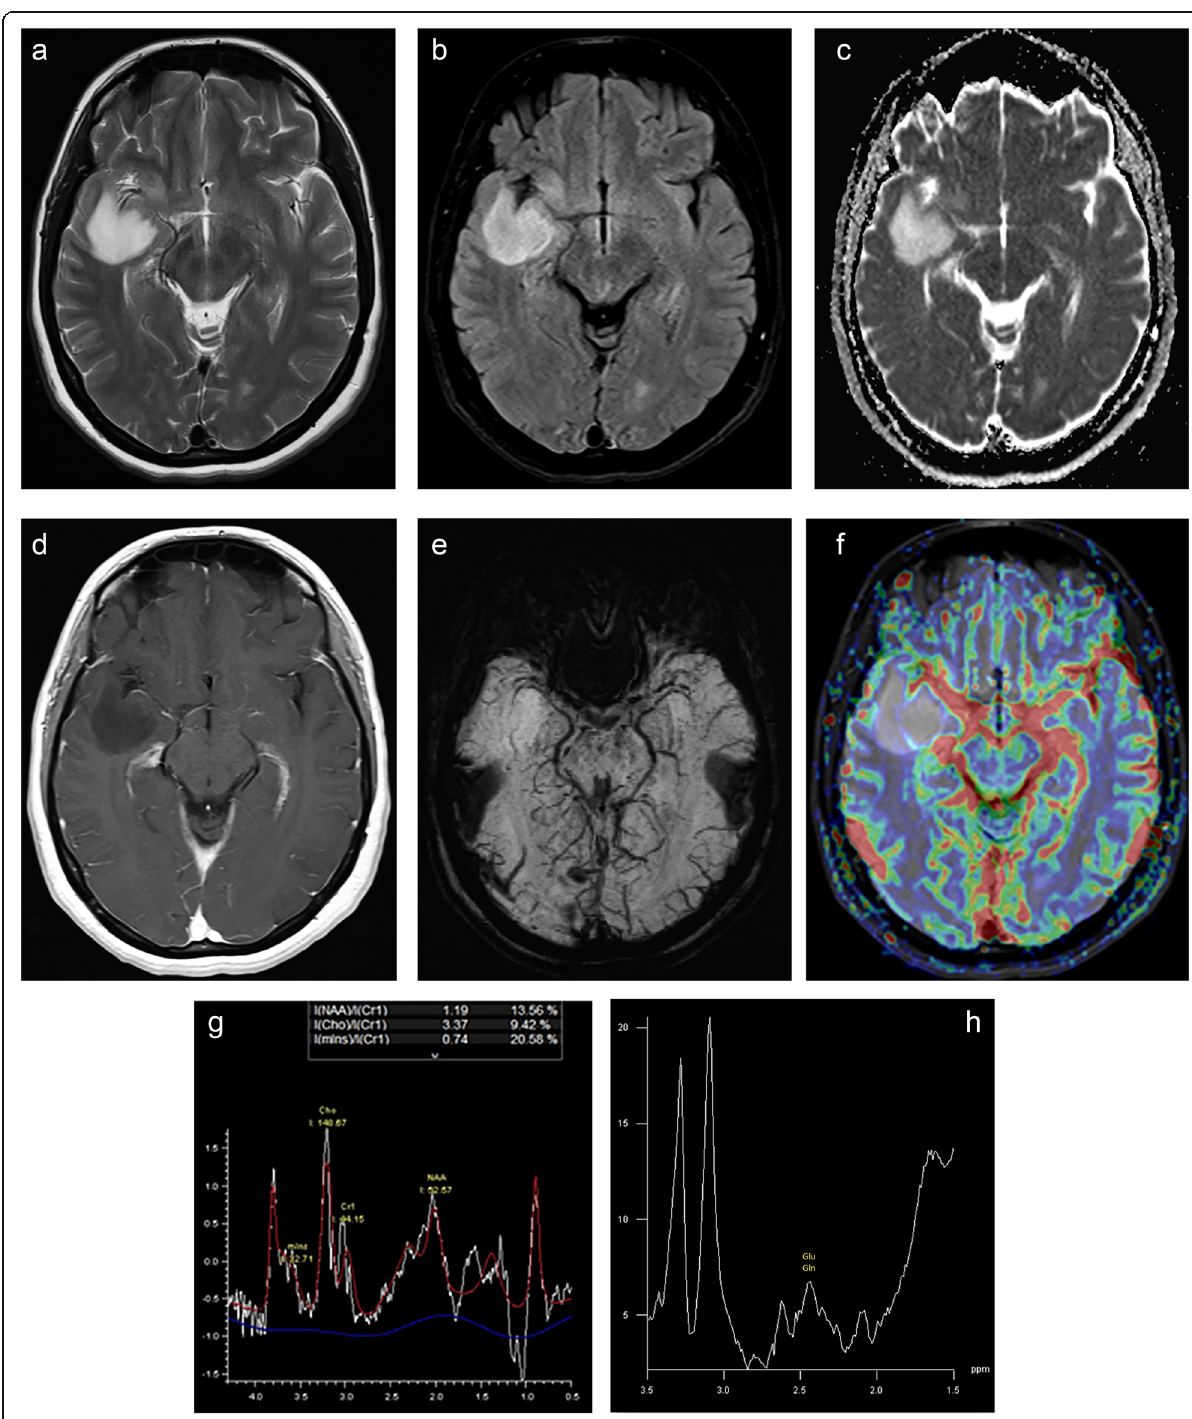
Fig. 2 Astrocytoma, grade II with the absence of IDH1 mutation (IDH wild-type), loss of ATRX expression, 20% p53, and 3.3% Ki67 is located on the right temporal lobe on axial MR images. The tumor has a high signal on T2 ( a ), FLAIR ( b ), and ADC ( c ) images and faint enhancement on post-contrast T1-weighted image ( d ). The tumor has low ITSS on SW image ( e ) and rCBV max values compared to normal parenchyma on the DSC-perfusion image ( f ). The tumor has increased Cho/Cr ratio and low NAA/Cr ratio on the MR spectrum obtained by 144 ms echo time ( g ). The high-resolution MR spectroscopy by 69 ms of echo time ( h ) reveals a singlet due to the glutamine-glutamate complex (Glu-Gln), which is consistent with the absence of 2-HG peak and IDH1